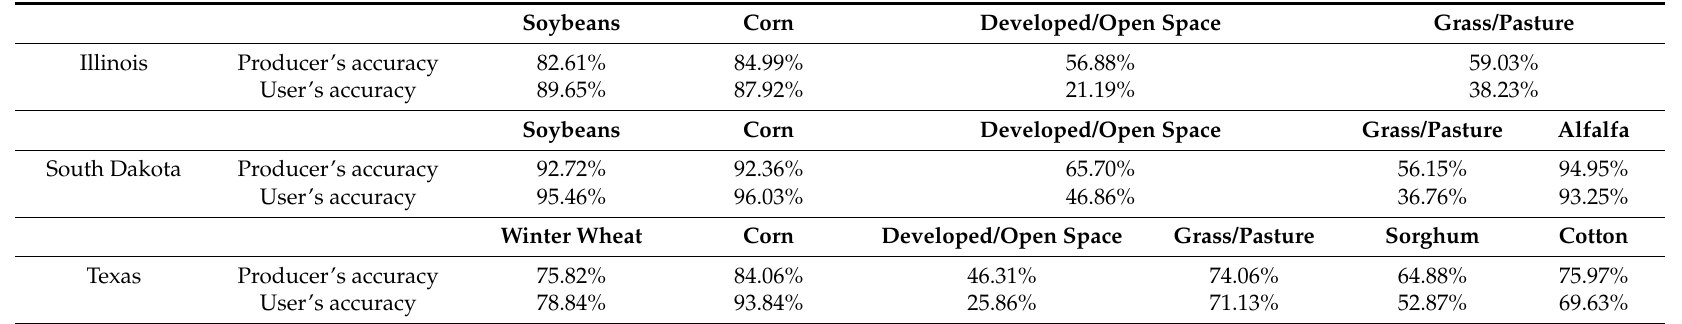
Table 7. Mean producer and user accuracies of classification based on STS (using RF classifier)